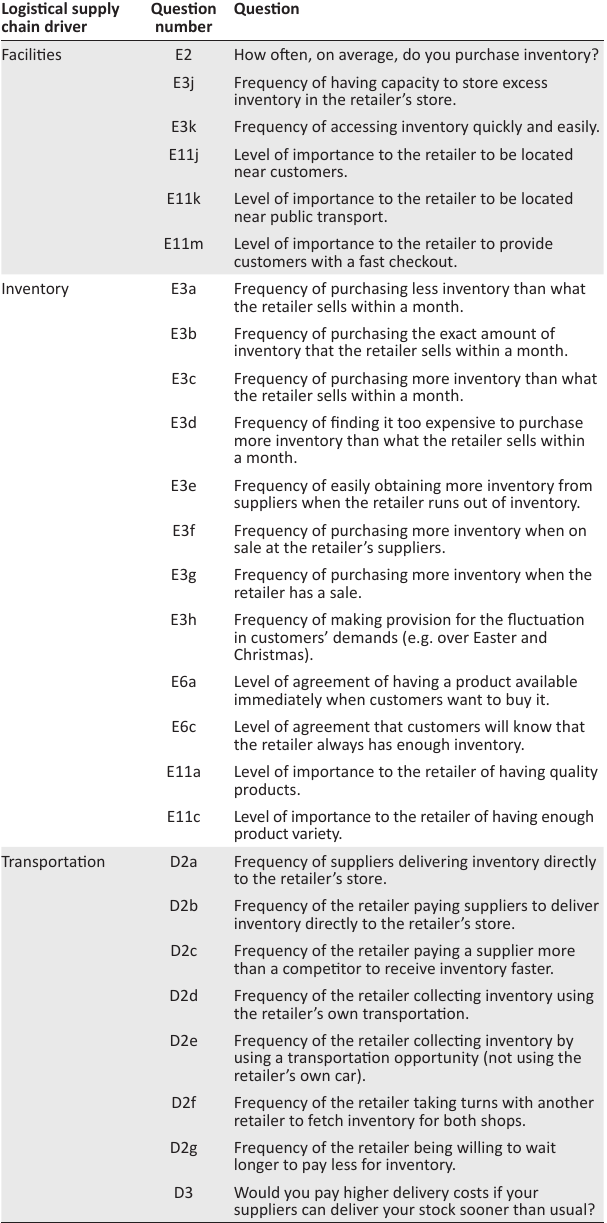
of independent variables of the binary logistics model. TABLE 2: Actual questions pertaining to the management of the logistical supply